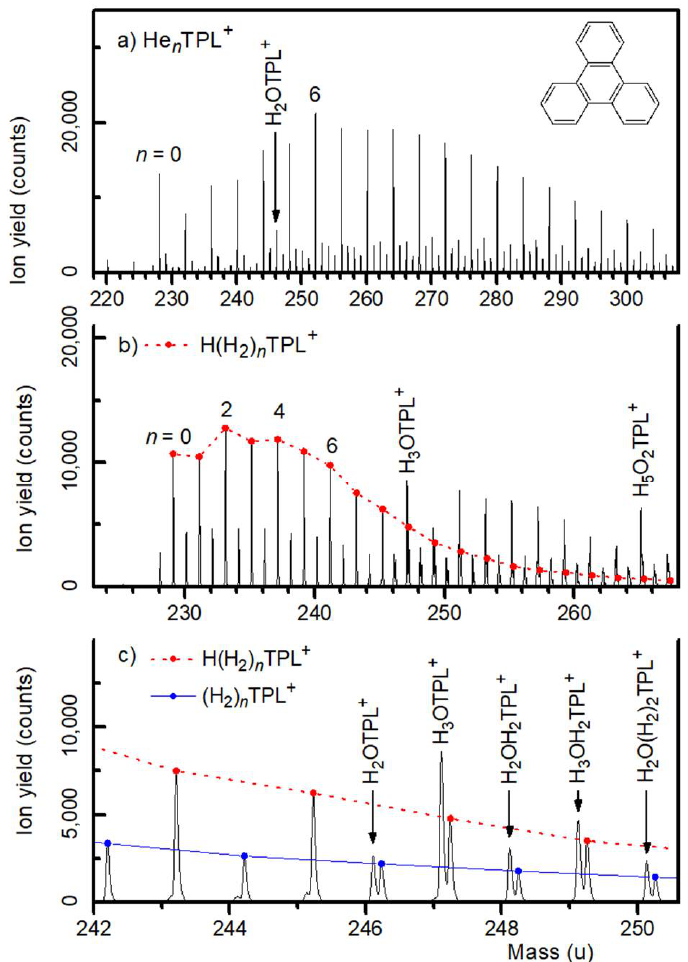
Figure 1. Panels ( a , b ): Mass spectra of triphenylene (TPL, C 18 H 12 , mass 228.094 u) cations complexed with helium and hydrogen, respectively. In panel ( b ), mass peaks due to protonated H(H 2 ) n TPL + ions are connected by a dotted line. Panel ( c ) shows a narrow section of the spectrum in panel ( b ). Mass peaks due to H(H 2 ) n TPL + and (H 2 ) n TPL + are connected by dotted and solid lines, respectively. Mass peaks arising from a water contamination are resolved.